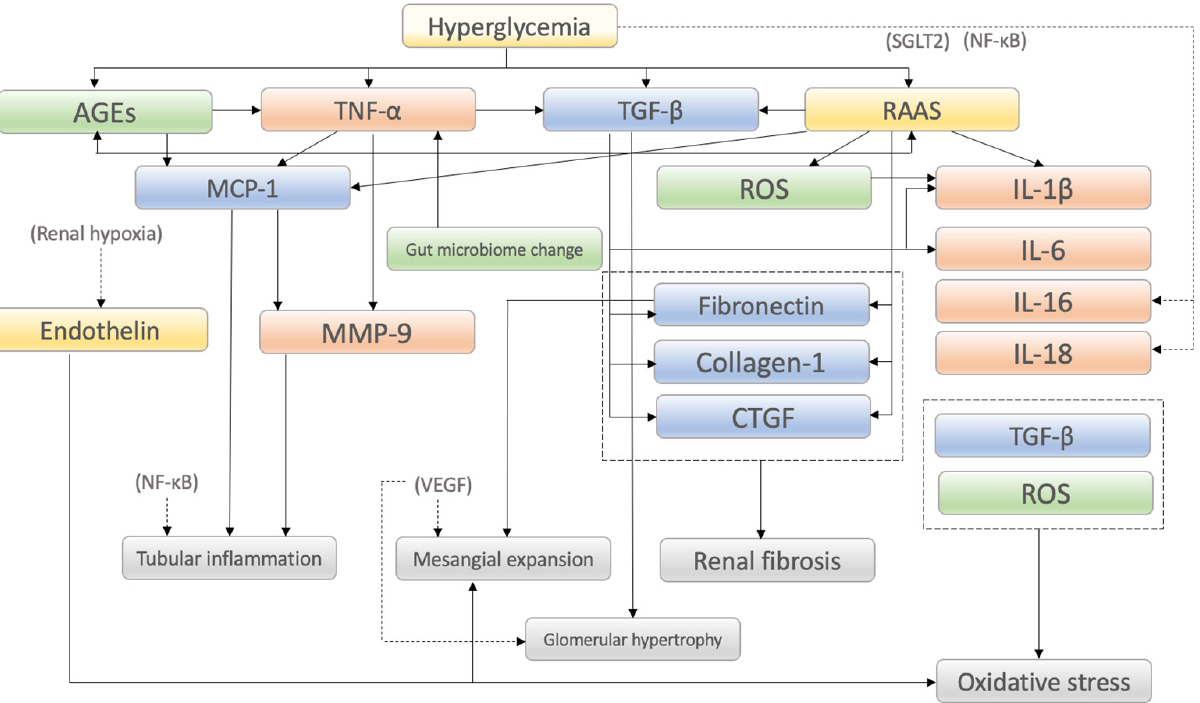
Figure 2. Summary of the molecular interplay that affects onset and progression of diabetic kidney disease (DKD). SGLT2, sodium glucose cotransporter 2; NF- κ B, nuclear factor-kappa B; AGEs, advanced glycation end products; TNF- α , tumor necrosis factor- α ; TGF- β , transforming growth factor- β ; RAAS, renin–angiotensin–aldosterone system; MCP-1, monocyte chemoattractant protein-1; ROS, reactive oxygen species; IL-1 β , interleukin-1 β ; IL-6, interleukin-6; IL-16, interleukin-16; IL-18, interleukin-18; MMP-9, matrix metalloproteinase-9; CTGF, connective tissue growth factor.